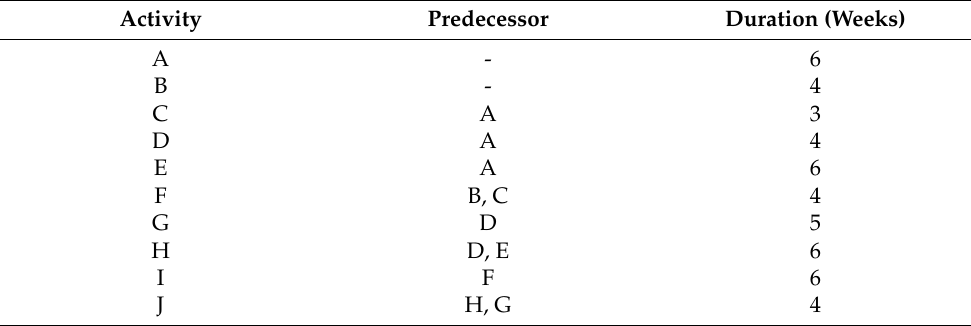
Table 3. Project tasks, precedence between tasks, and their respective durations.